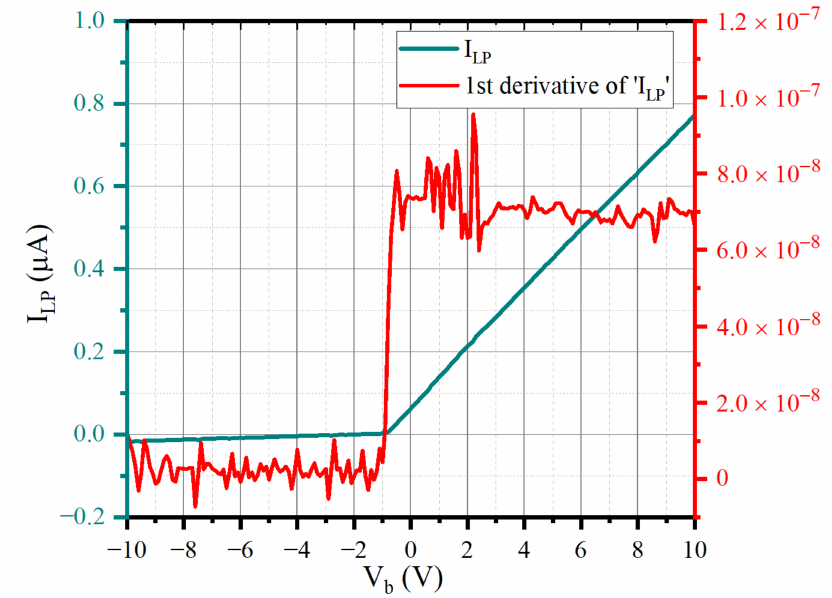
Figure 3. The I–V characteristic curve without obvious saturation